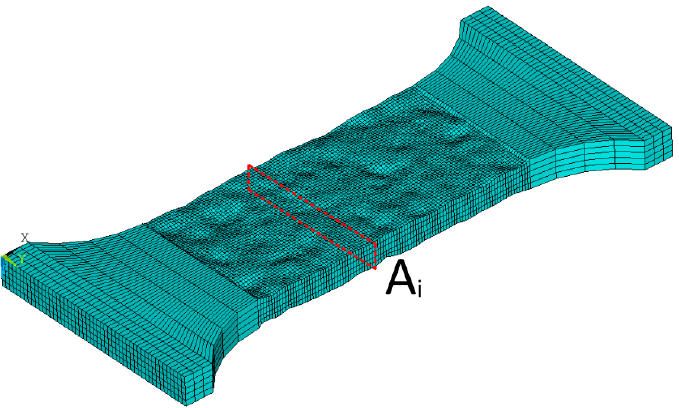
Figure 8. Finite element model of a specimen with a randomly generated corroded surface